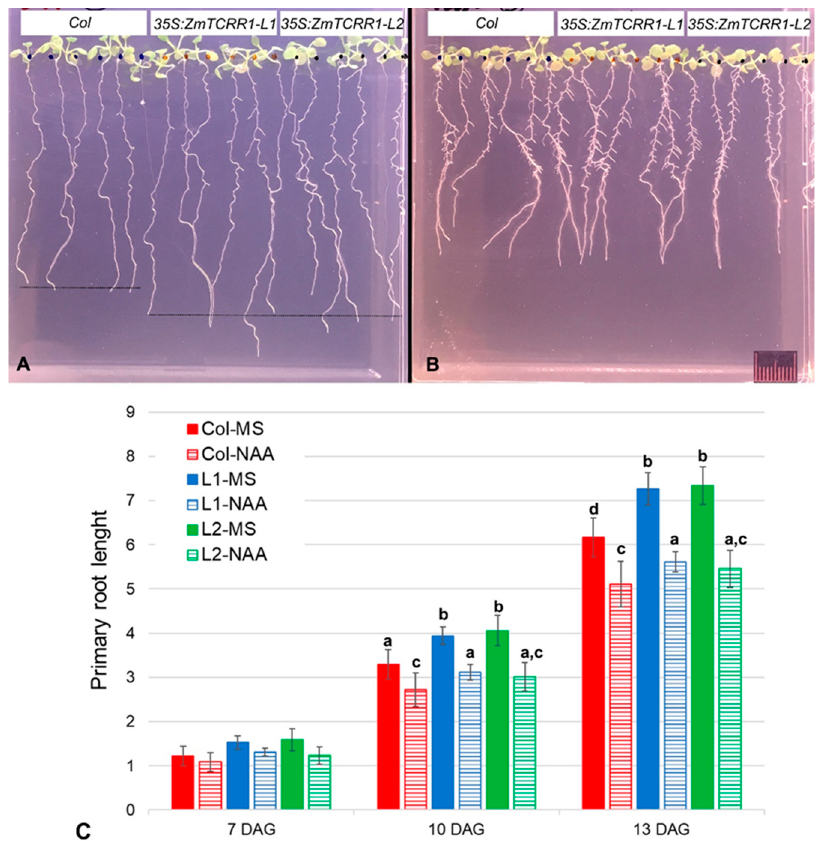
Figure 5. ZmTCRR1 interferes with auxin signalling. Seeds from wild type (Col) and two independent homozygous transgenic lines (L1, L2) overexpressing ZmTCRR1 were cultured in vertical plates with MS media containing no hormone or 125 nM NAA. The upper panel shows a representative set of plates after 13 days in culture. ( A ), no hormone; ( B ), 125 nM NAA. Dot lines in ( A ) highlight the difference in growth between Col and the transgenic lines. The rule in ( B ) is 1 cm. ( C ), average primary root length (in cm) of each genotype in each culture media after 7, 10, and 13 days after germination (DAG). The error bars represent the standard deviation. The transgenic lines show nearly identical behaviour and a consistently faster primary root growth than the WT plants in the absence of hormone. However, after 10 days of culture, ZmTCRR1 plants in the presence of 125 nM NAA are in a statistically homogeneous group with WT (Col) plants in the absence of hormone, and this group is statistically distinct ( p < 0.05) from that formed by the ZmTCRR1 plants in the absence of hormone. According to pairwise comparisons, letters on the columns identify statistically homogeneous classes (Bonferroni test, 95% confidence).